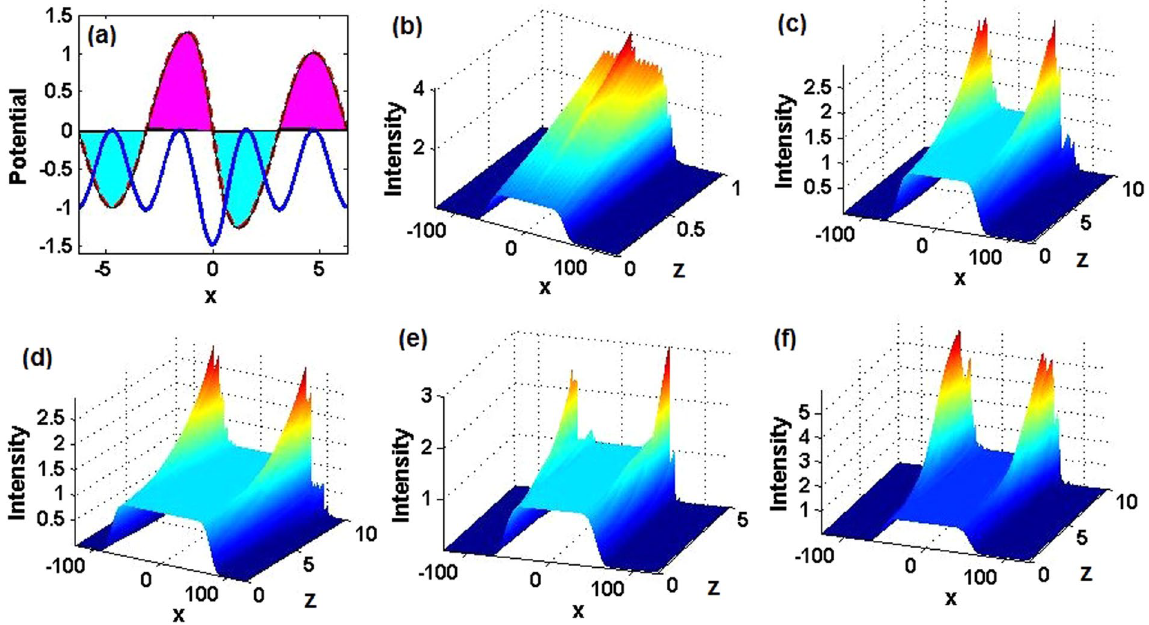
Figure 8. Constant-intensity waves in linear and nonlinear PT -symmetric systems with the complex potential of cos type. The same as in Figs. 6 and 7, but for the PT -symmetric complex potential of the cos type, see the